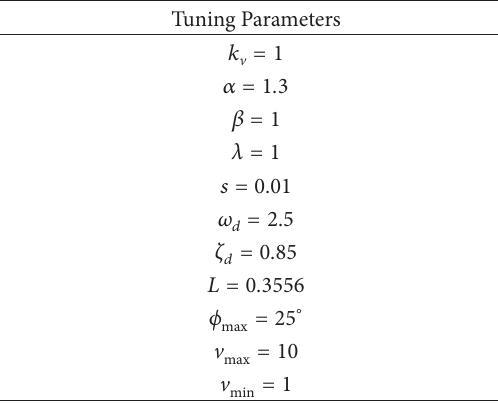
Table 3: Potential field tuning constants for experiments. Table 4: Common controller tuning parameters for